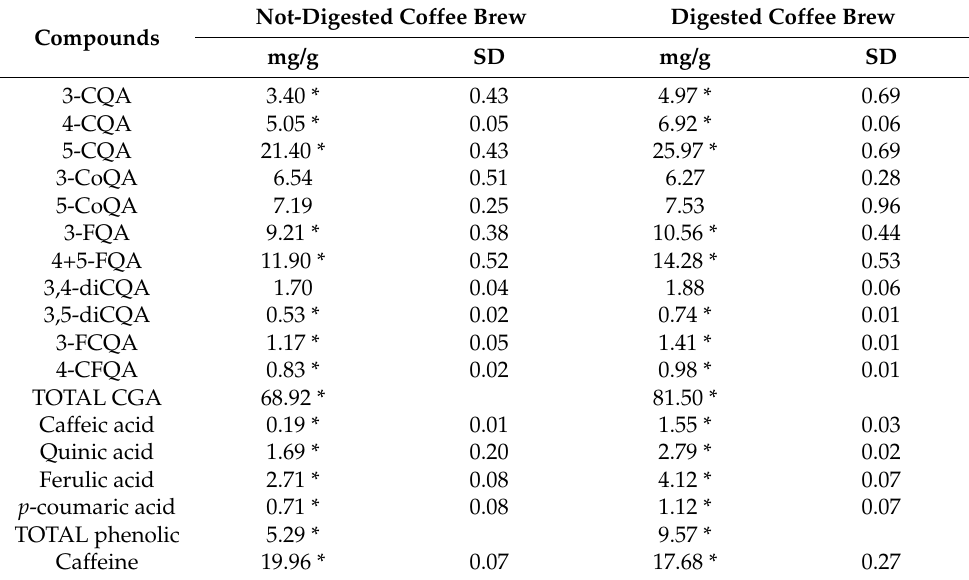
Table 2. CGA ( n = 11), phenolic acids ( n = 4), and caffeine content in the assayed samples.